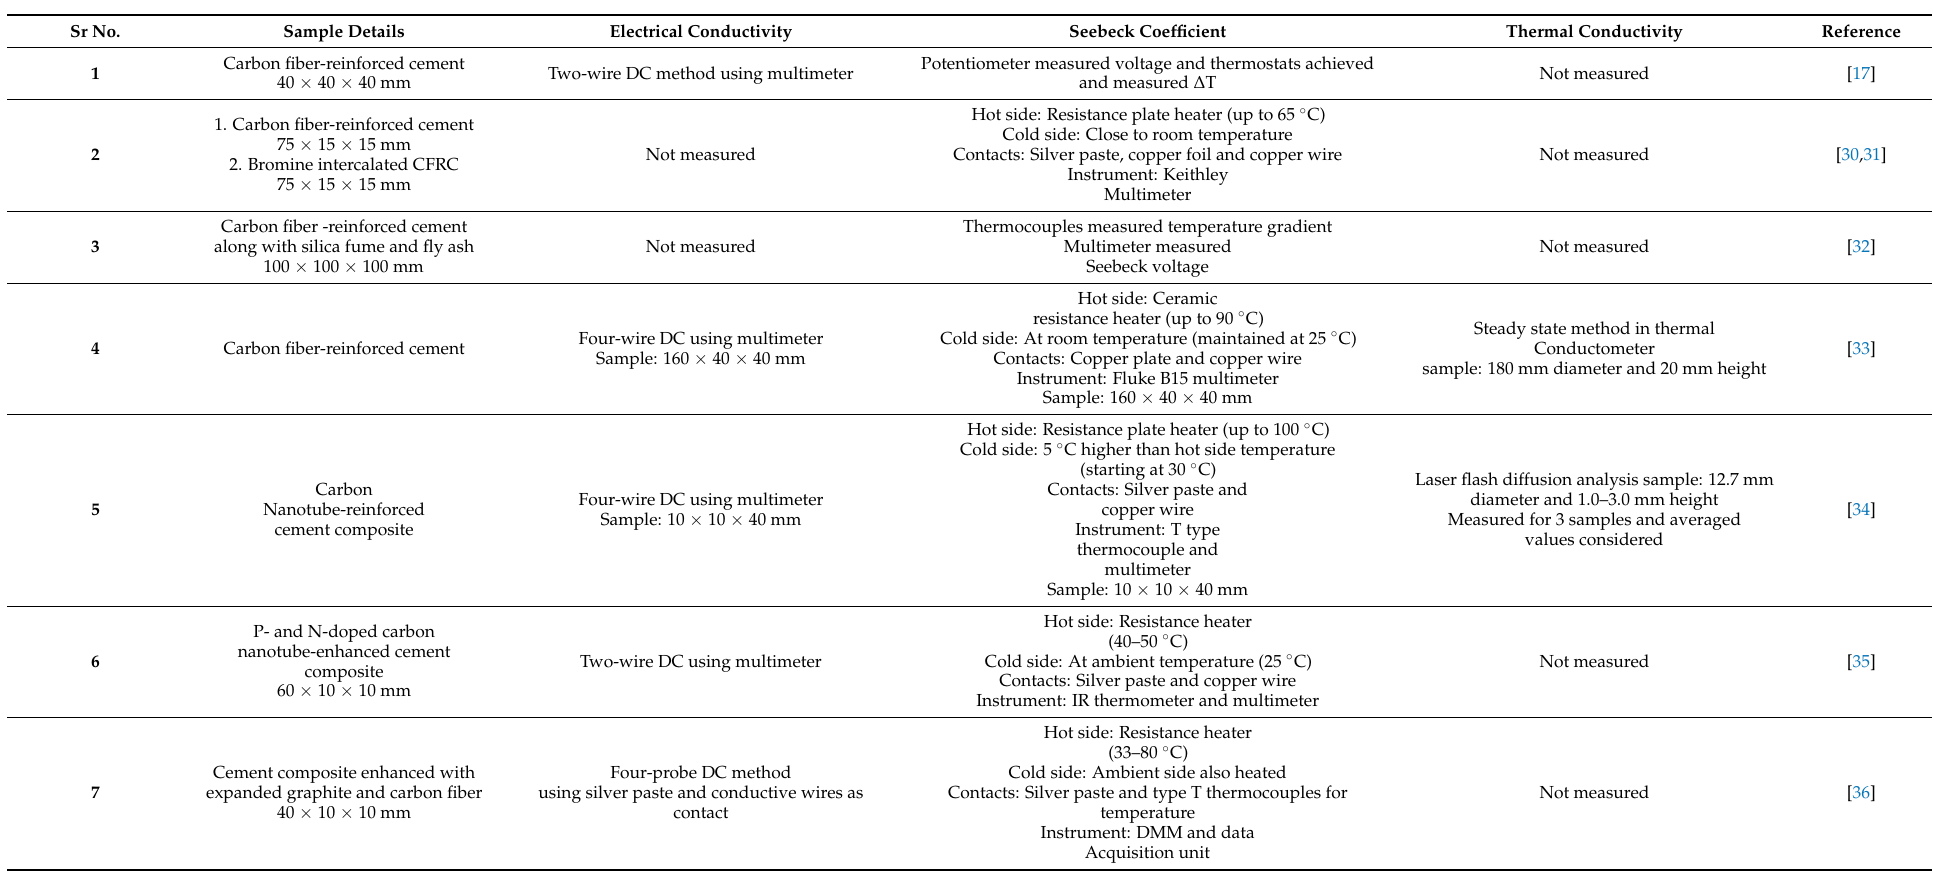
Table 1. Comparison of characterization techniques and methods used for thermoelectric characterization of cement-based materials developed to date in the literature. Sr